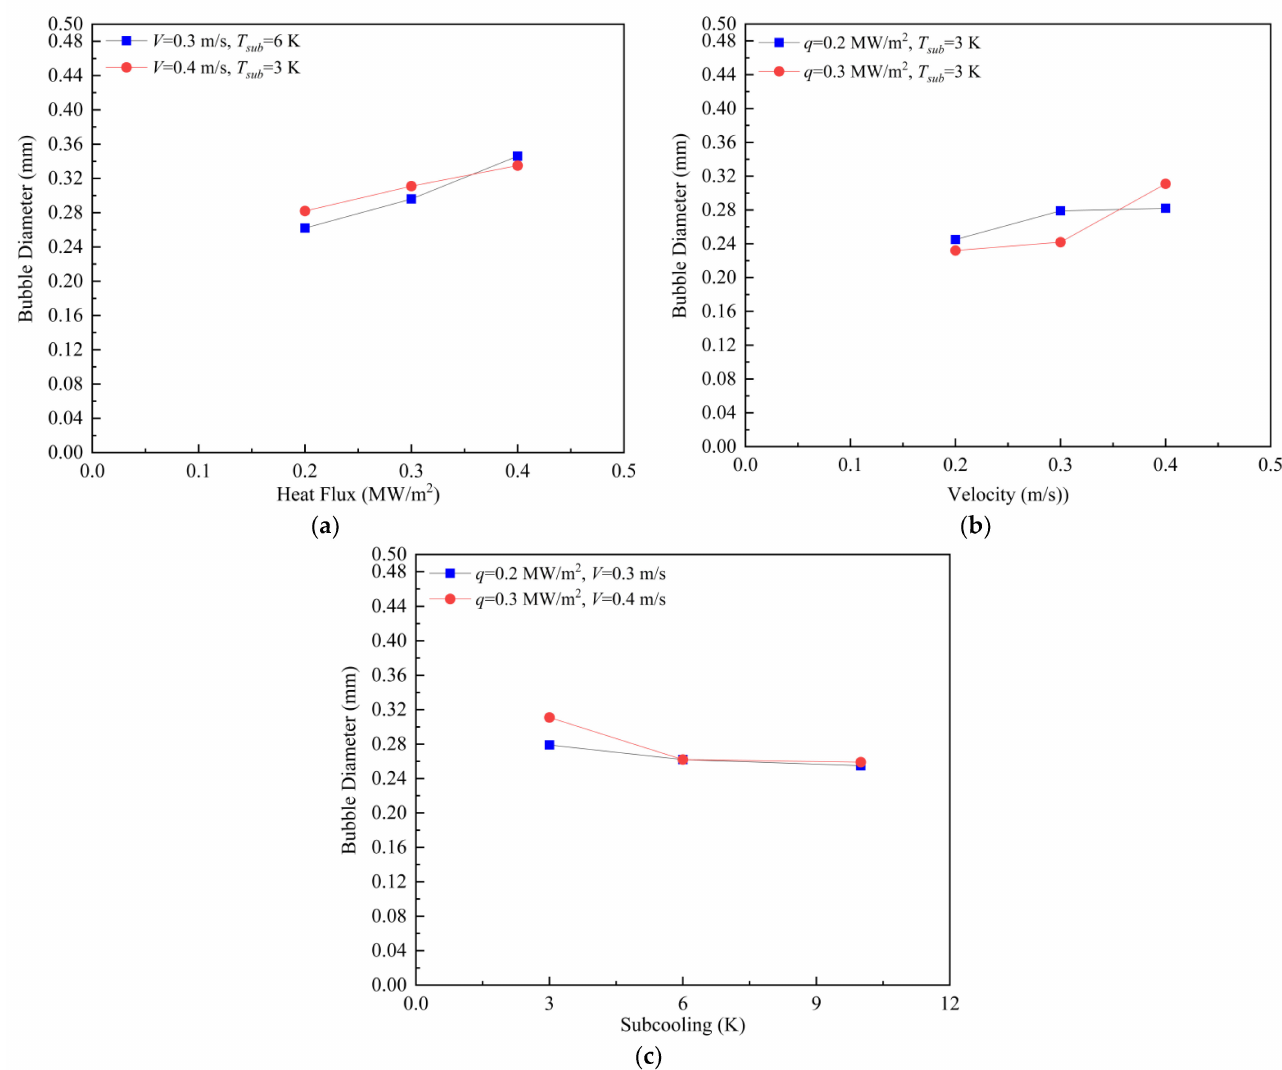
Figure 15. The effect of different factors on average departure diameter: ( a ) the effect of heat flux; ( b ) the effect of inlet velocity; ( c ) the effect of inlet